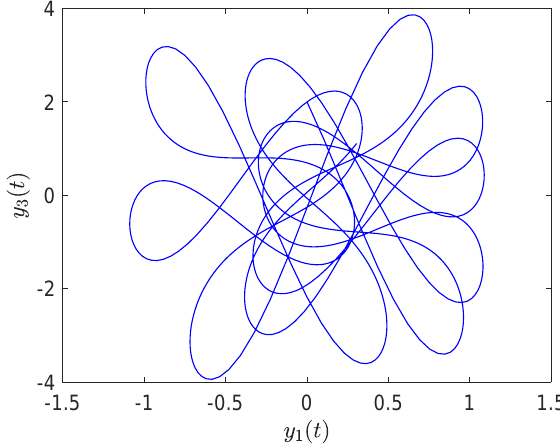
Figure 35. Phase portraits of y 1 and y 3 .